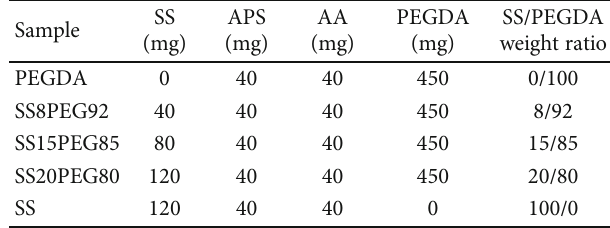
Table 1: Initial feed compositions of di ff erent SS hydrogel